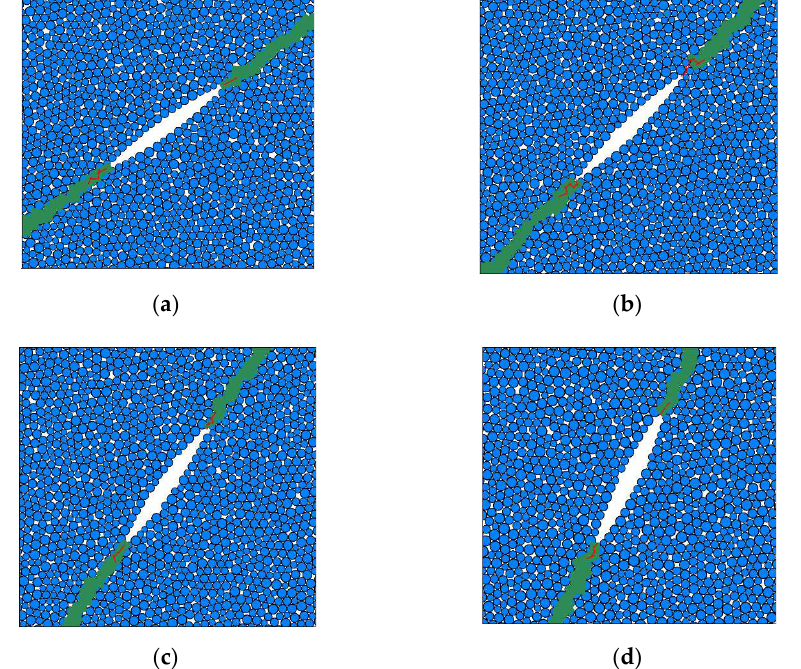
Figure 8. Initiation stress of interface crack with different joint inclination angles. ( a ) β = 35.8°